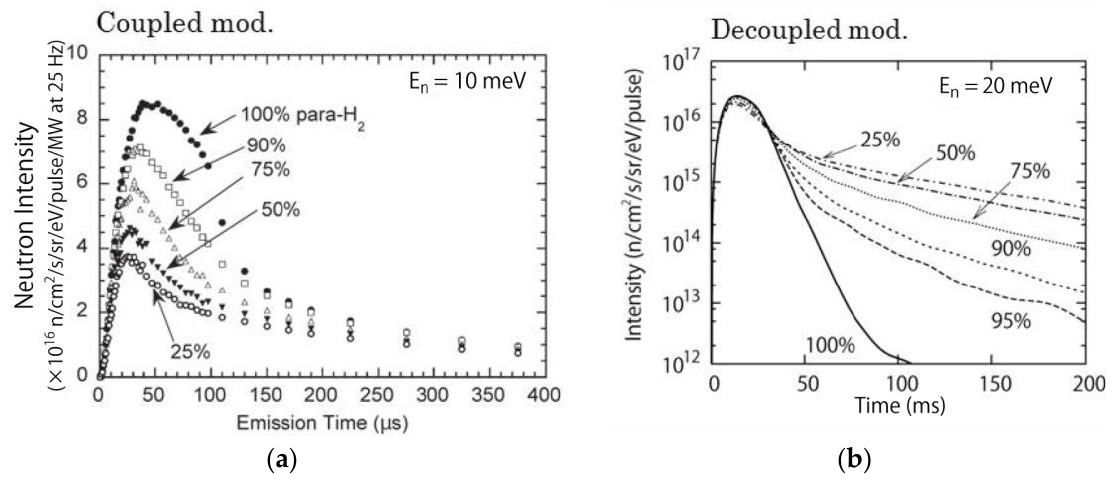
Figure 12. Para-hydrogen concentration dependence on pulse shapes for the coupled moderator ( a ) [30] and the de-coupled one ( b ) [38].